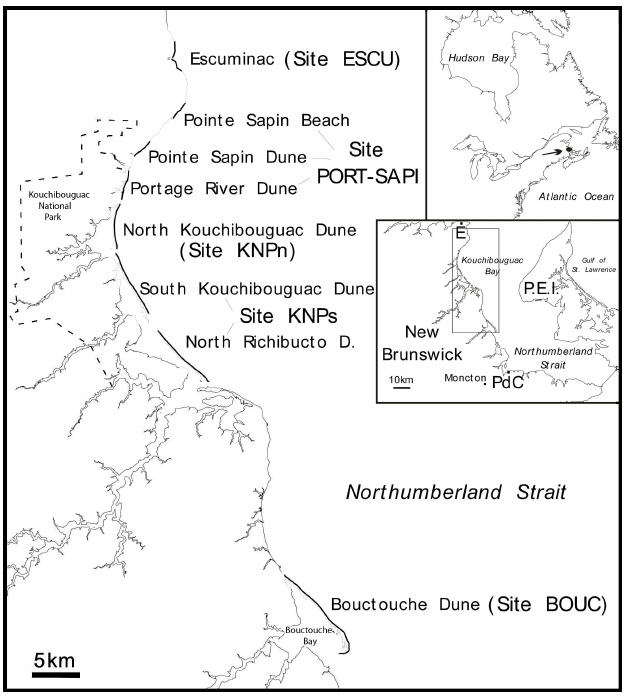
Fig. 1 . Map of the study area, showing the five study sites (beaches). Inset (center right): location of the tide-gauge stations referred to in the text: E and PdC denote tide-gauge stations at Escuminac and Pointe-du-Chêne,